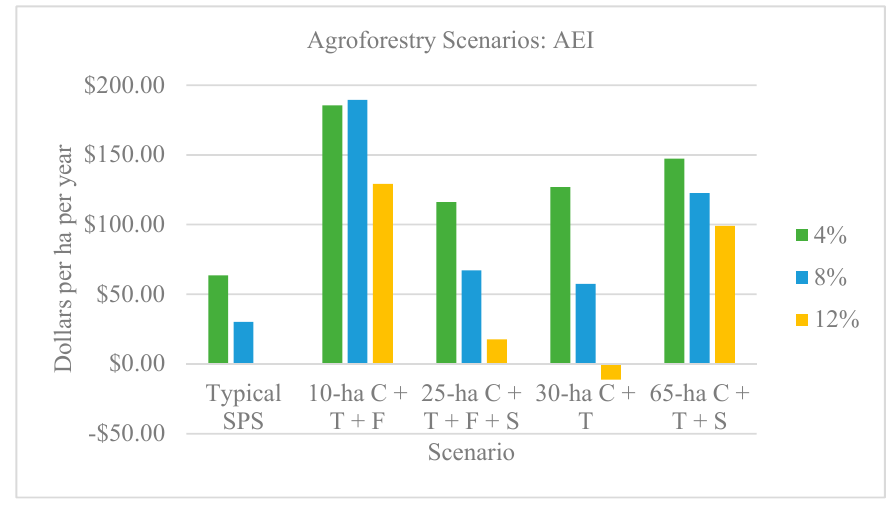
Figure 1. Annual equivalent income (AEI) of traditional forest and cattle systems.